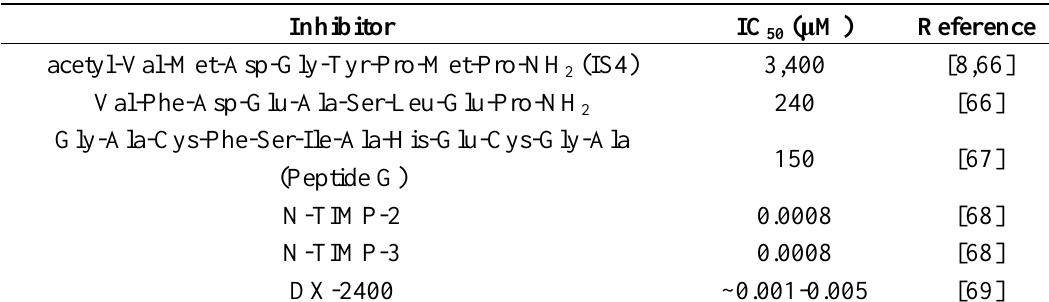
Table 2. Inhibitors of MT1-MMP catalytic